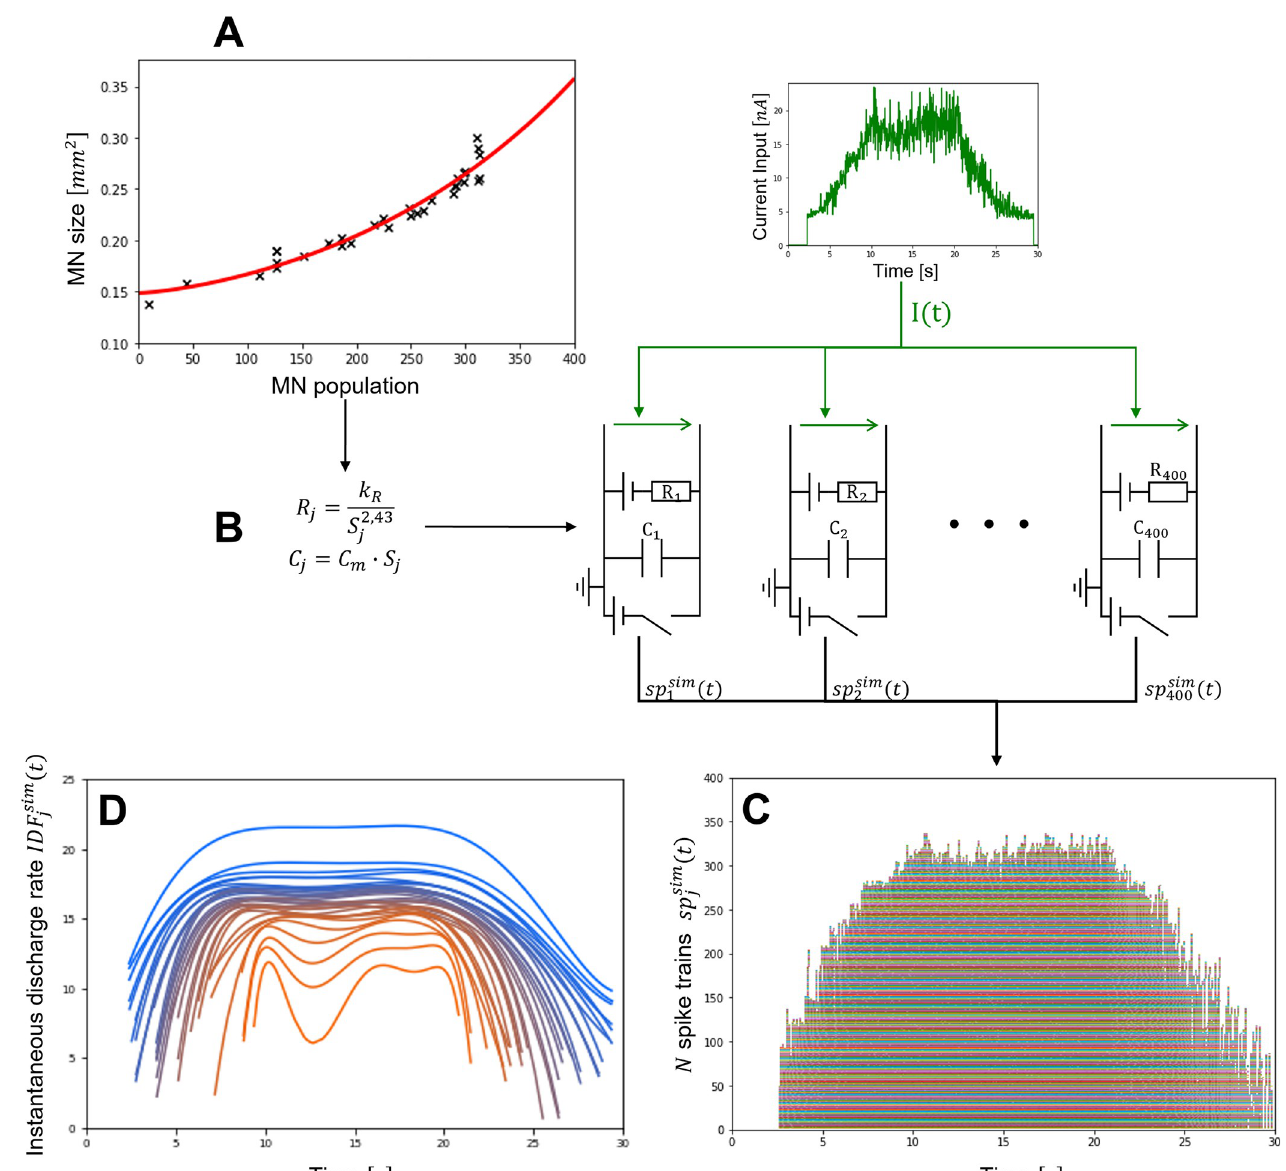
Fig 10. Reconstruction of the firing behaviour and recruitment dynamics of the complete MN pool. (A) The N calibrated MN sizes (black crosses) are lest- r ð Þ 1 : 47 j N squares fitted by the power trendline S j ð Þ m 2 ½ � ¼ 1 : 49 � 10 (cid:0) 7 � D , which reconstructs the distributions of MN sizes in the complete MN pool. (B) The S ( j ) S distribution determines the MN-specific R and C parameters of a cohort of N LIF models, which is driven by the current input I ( t ) and predicts (C) the spike ð t Þ of the N virtual MNs constituting the complete MN pool. (D) The MN instantaneous discharge frequencies were computed from the simulated trains sp sim j the spike trains sp sim ð t Þ and were smoothed with a sixth-order polynomial [55]. One out of ten IDFs is displayed for clarity. The blue-to-red gradient for small- j to-large MNs shows that the output behaviour of the reconstructed MN population is in agreement with the Onion-Skin scheme. https://doi.org/10.1371/journal.pcbi.1010556.g010 trace F ð t Þ (green trace in Fig 13). The eND was accurately predicted for the datasets DTA 35 N and HTA , with r 2 = 0.97 − 0.98 and nRMSE < 8% (Table 3). The results obtained from the 35 dataset HGM returned r 2 = 0.89 and nRMSE = 18.2% (Table 3), accurately predicting the 30 for the positive ramp and first half of the plateau of force and then underestimating the eND N true neural drive ( HGM , Fig 13). The eND predicted for the dataset HTA returned results 30 50 N